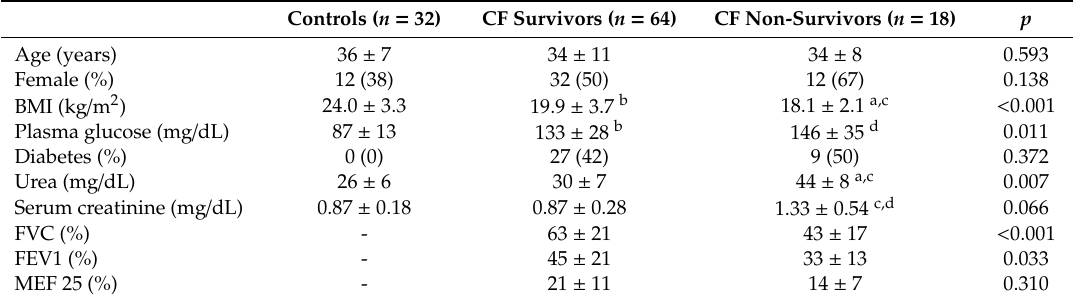
Table 1. Demographic characteristics and clinical parameters of the study population.